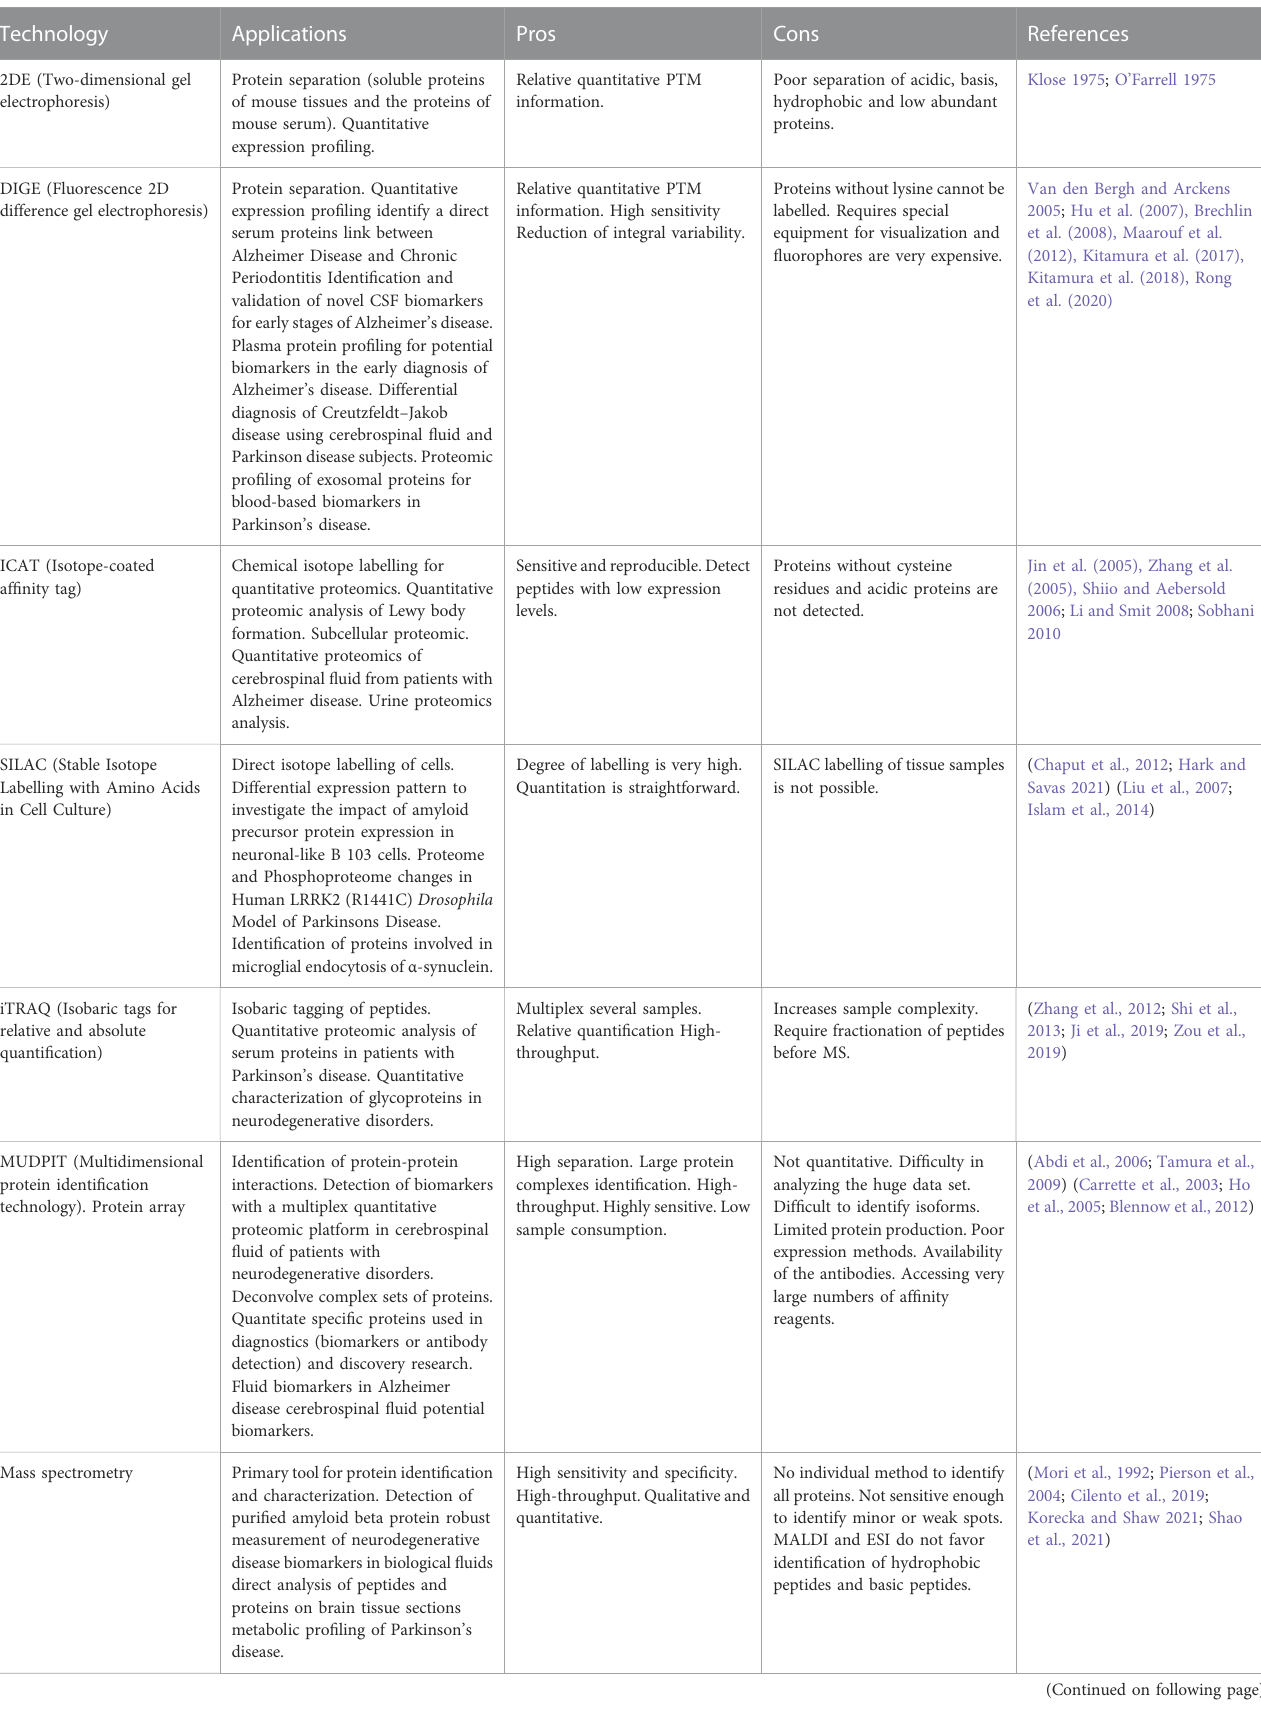
TABLE 1 Various Techniques used in Proteomics along with their applications.